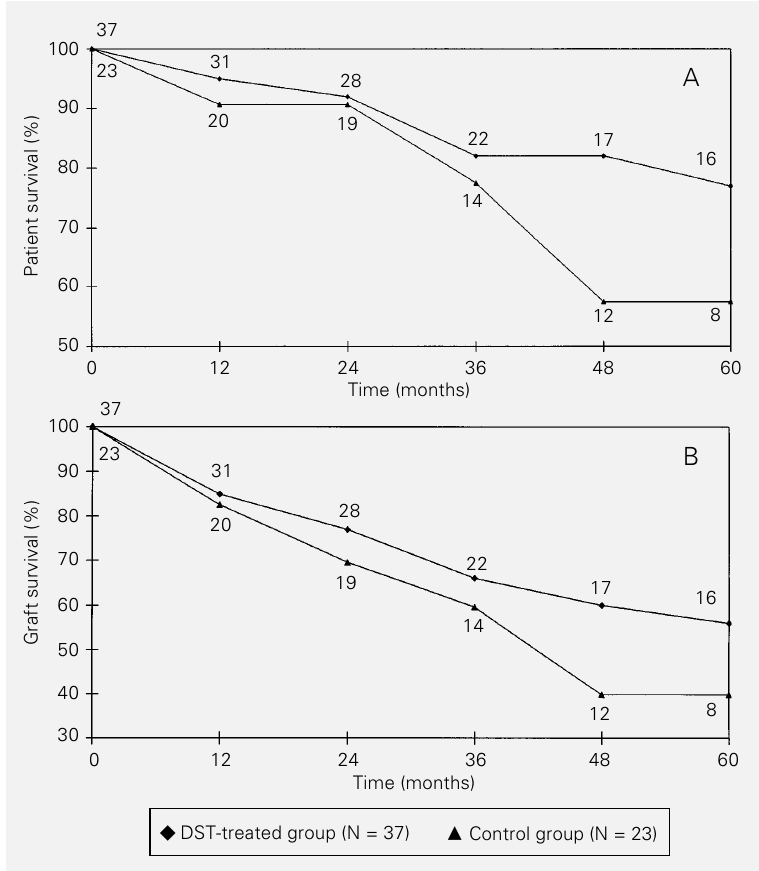
Figure 1 - A , Actuarial patient survival. B , Actuarial graft